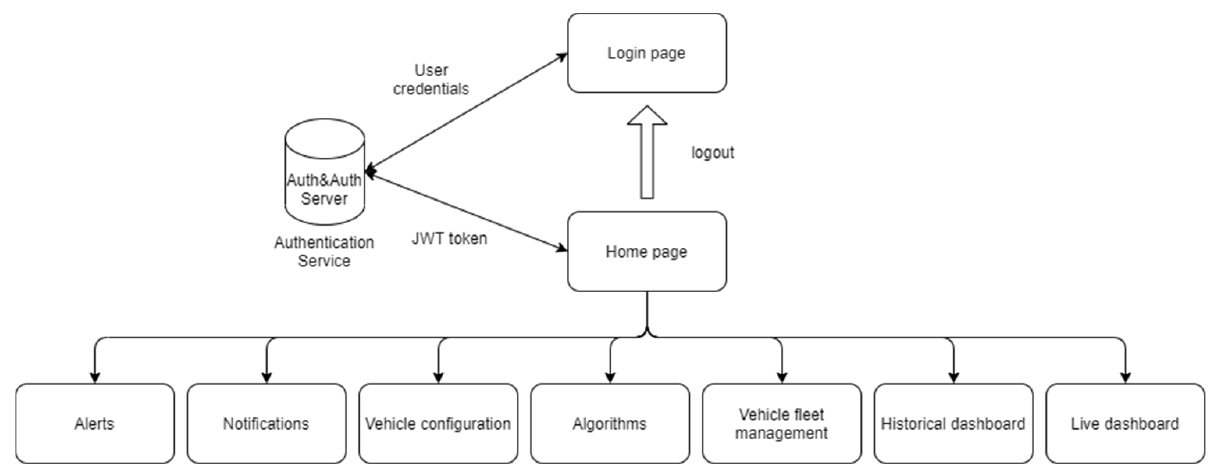
Figure 11. Website map of the HMI application.